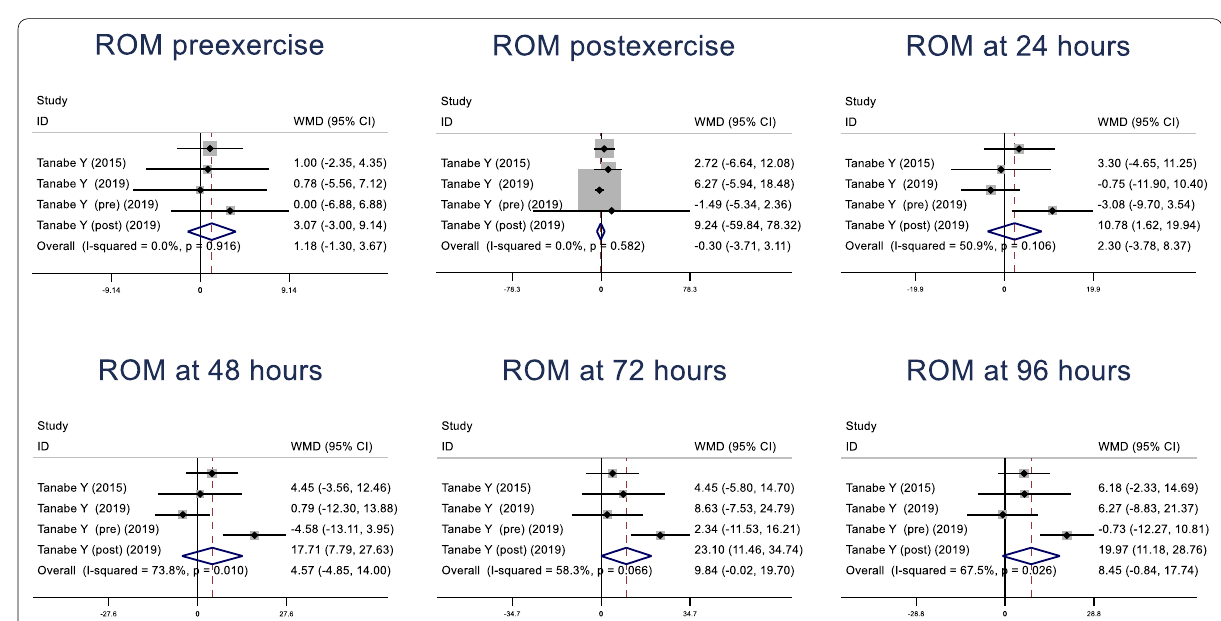
Fig. 6 Forest plot for comparison of ROM score at pre-, post-, 24, 48, 72 and 96 h after exercise between curcumin supplement versus